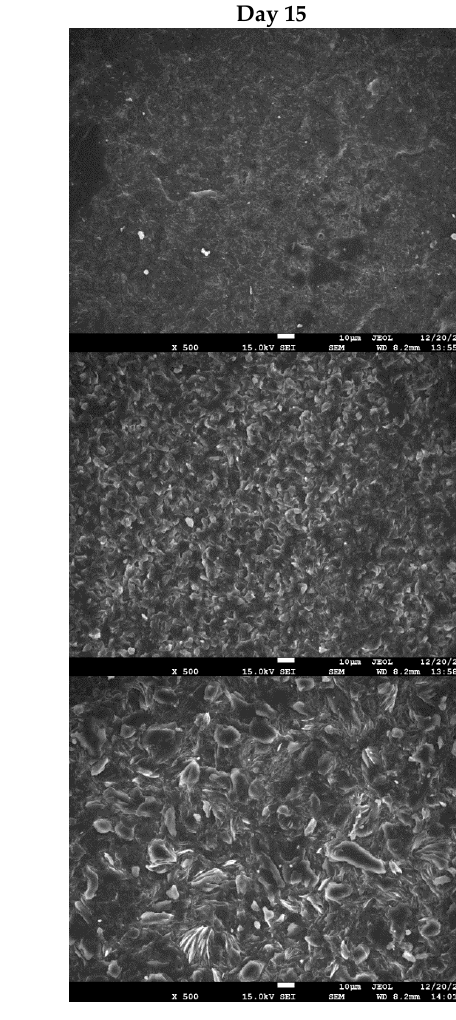
Figure 6. SEM images of surfaces for the PCL copolymers, initially (Day 0) and after 15 days of enzymatic hydrolysis. enzymatic